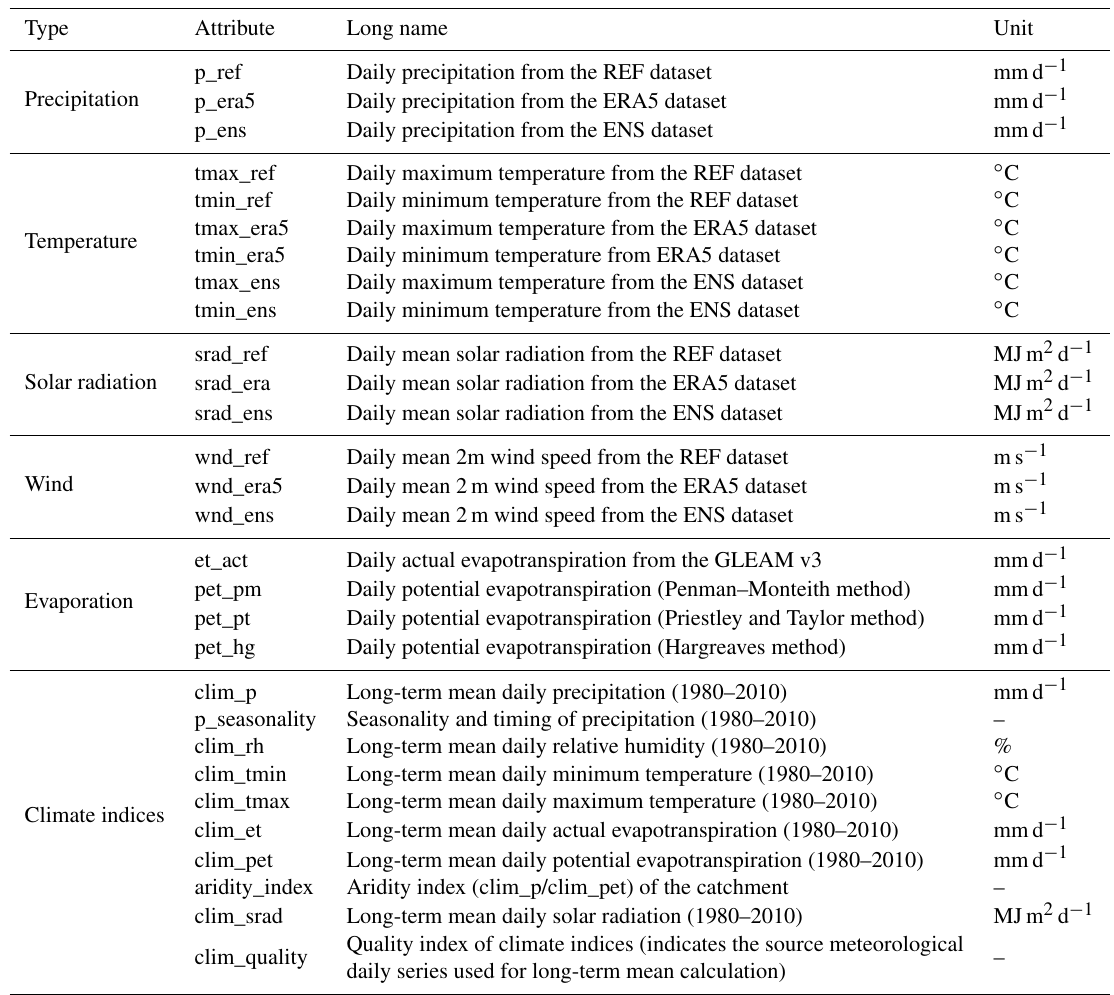
Table 3. Daily series of meteorological variables and climate indices for the CABra catchments. Type Attribute Long name Unit p_ref Daily precipitation from the REF dataset Precipitation p_era5 Daily precipitation from the ERA5 dataset p_ens Daily precipitation from the ENS dataset mmd − 1 tmax_ref Daily maximum temperature from the REF dataset ◦ C tmin_ref Daily minimum temperature from the REF dataset ◦ C tmax_era5 Daily maximum temperature from the ERA5 dataset ◦ C Temperature tmin_era5 Daily minimum temperature from ERA5 dataset ◦ C tmax_ens Daily maximum temperature from the ENS dataset ◦ C tmin_ens Daily minimum temperature from the ENS